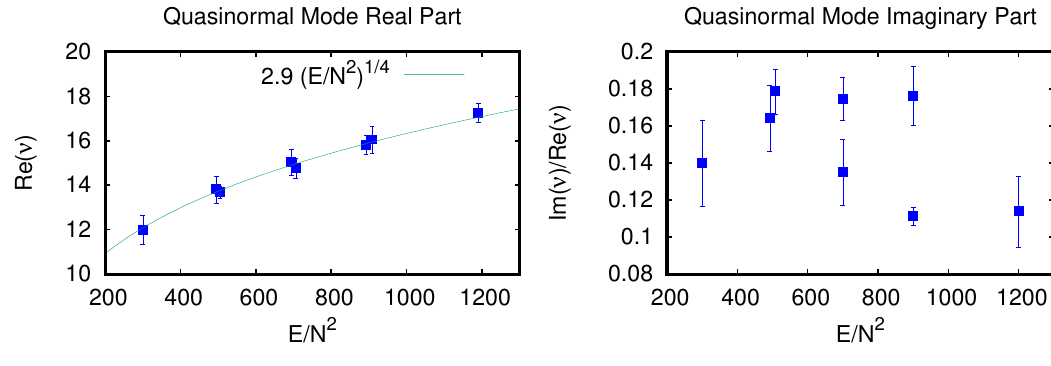
Figure 9 . Real and imaginary part of lowest-lying presumptive quasinormal mode frequency (cid:23) as a function of (cid:12)nal system energy for N = 32. Multiple entries correspond to quenching protocols with di(cid:11)erent initial, but the same (cid:12)nal energy, e.g. E=N 2 = 500 ! 700 and E=N 2 = 900 ! 700, and have been slightly displaced on the plot to increase